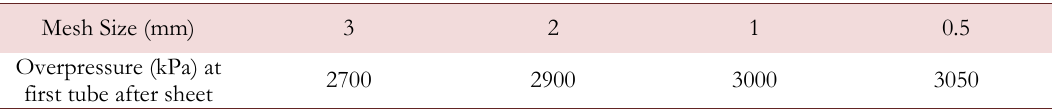
Table 7: Non-dependence on air mesh.